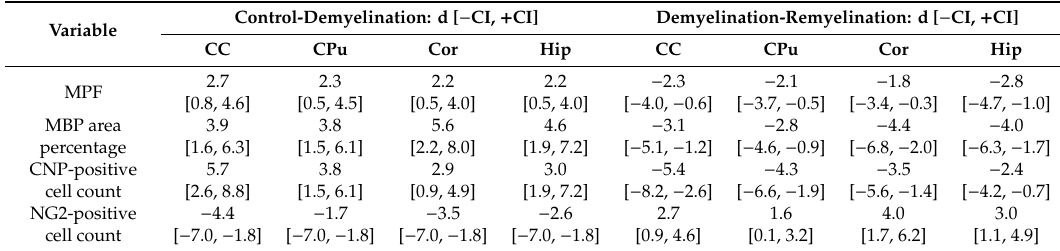
Figure 6. Summary statistics of MPF measurements and quantitative histological variables in the brain anatomic structures across the control, demyelination, and remyelination animal groups: MPF values ( a ), myelin content according to the percentage of MBP staining area ( b ), the count of myelinating oligodendrocytes (CNP-positive cells) ( c ), and OPC count (NG2-positive cells) ( d ). Anatomic structures are abbreviated as follows: CC—corpus callosum, Cor—cortex, CPu—caudate putamen, and Hip—hippocampus. Significant di ff erences between the groups according to the LSD test are marked by asterisks: * – p < 0.05, ** – p < 0.01, and *** – p < 0.001. Error bars represent standard errors of the mean. Table 1. E ff ect sizes (Cohen’s d) with 95% confidence intervals (CI) corresponding to the demyelination and remyelination states in the corpus callosum, caudate putamen, cortex, and hippocampus based on MPF and quantitative histology variables.